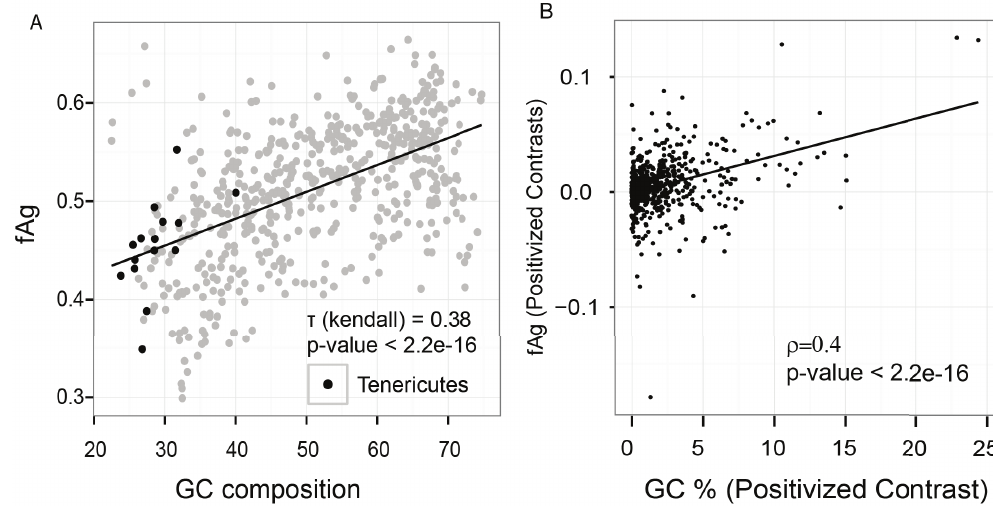
Figure 5. GC content is associated with fAg. ( A ) GC content of the genome correlates with the fraction of proteome that is aggregation- prone (fAg) (analysis of 570 bacterial genomes using the classifier). Rank-based correlation is provided along with the p-value. The black line shows a linear regression model. ( B ) The relationship between GC content and fAg was obtained through a phylogenetically independent contrast method (570 bacteria). A positive correlation (0.4) was identified between GC content and fAg (p-value < 2.1e-16).